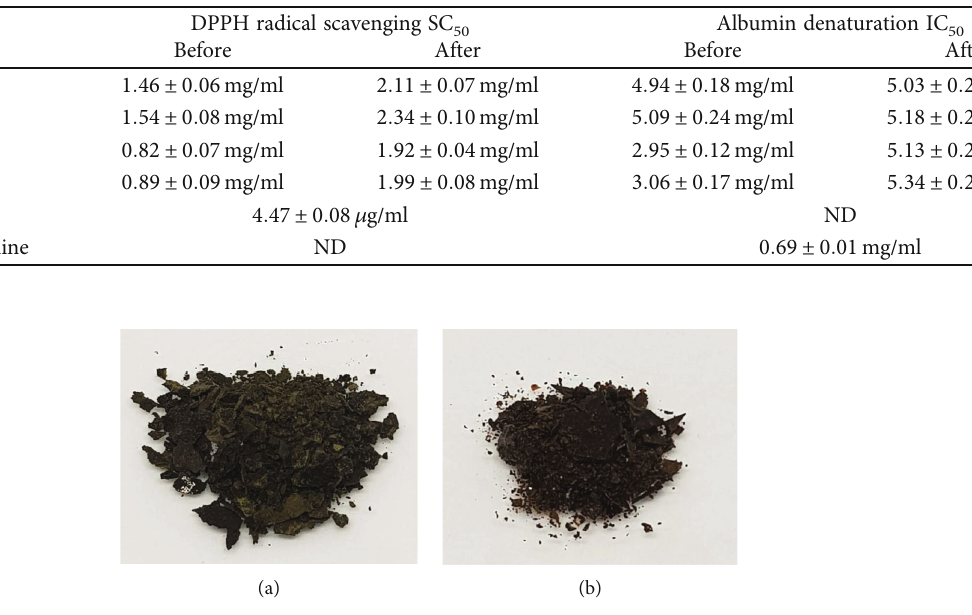
Figure 2: Ethanolic extracts of A. paniculata (a) and T. crispa (b).